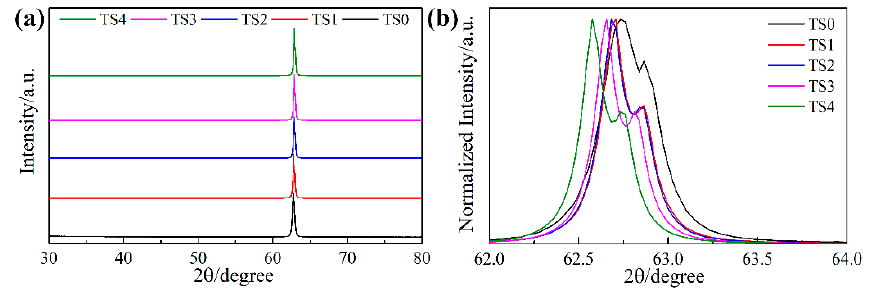
Figure 1. ( a ) X-Ray diffraction (XRD) patterns of pure TiO 2 NWAs (TS0) and Sn-doped TiO 2 NWAs (TS1, TS2, TS3, TS4), ( b ) enlarged XRD patterns of pure TiO 2 NWAs (TS0) and Sn-doped TiO 2 NWAs (TS1, TS2, TS3, TS4).